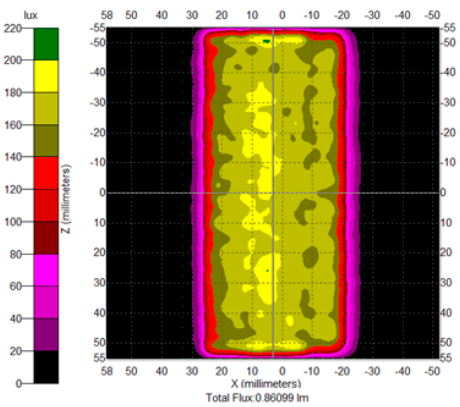
Figure 7. Illumination map of a light guide module measured by detector at 𝚯 𝐞 = 45°.